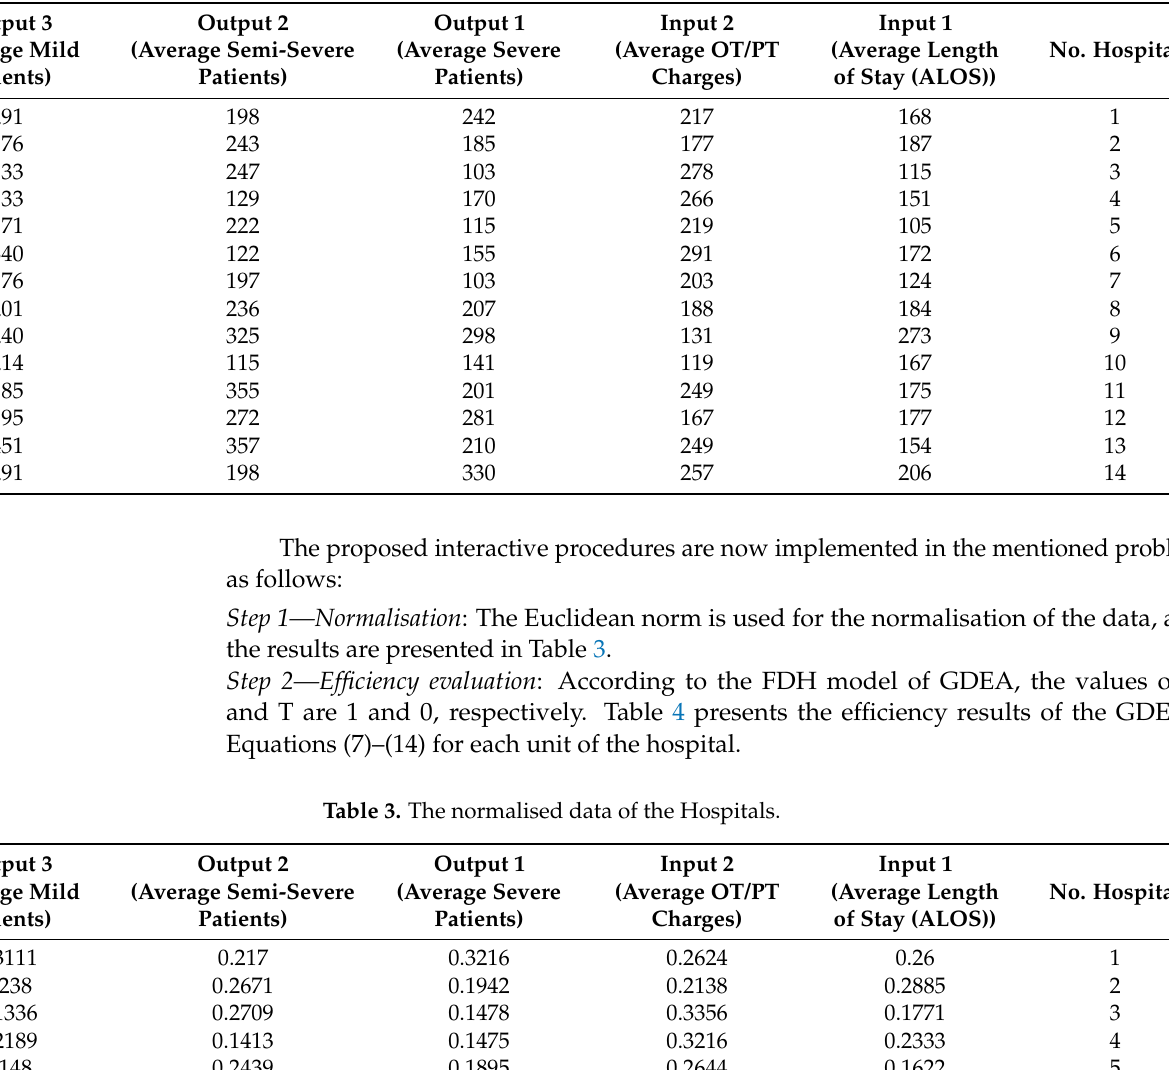
Table 2. The data relates to 14 hospitals.